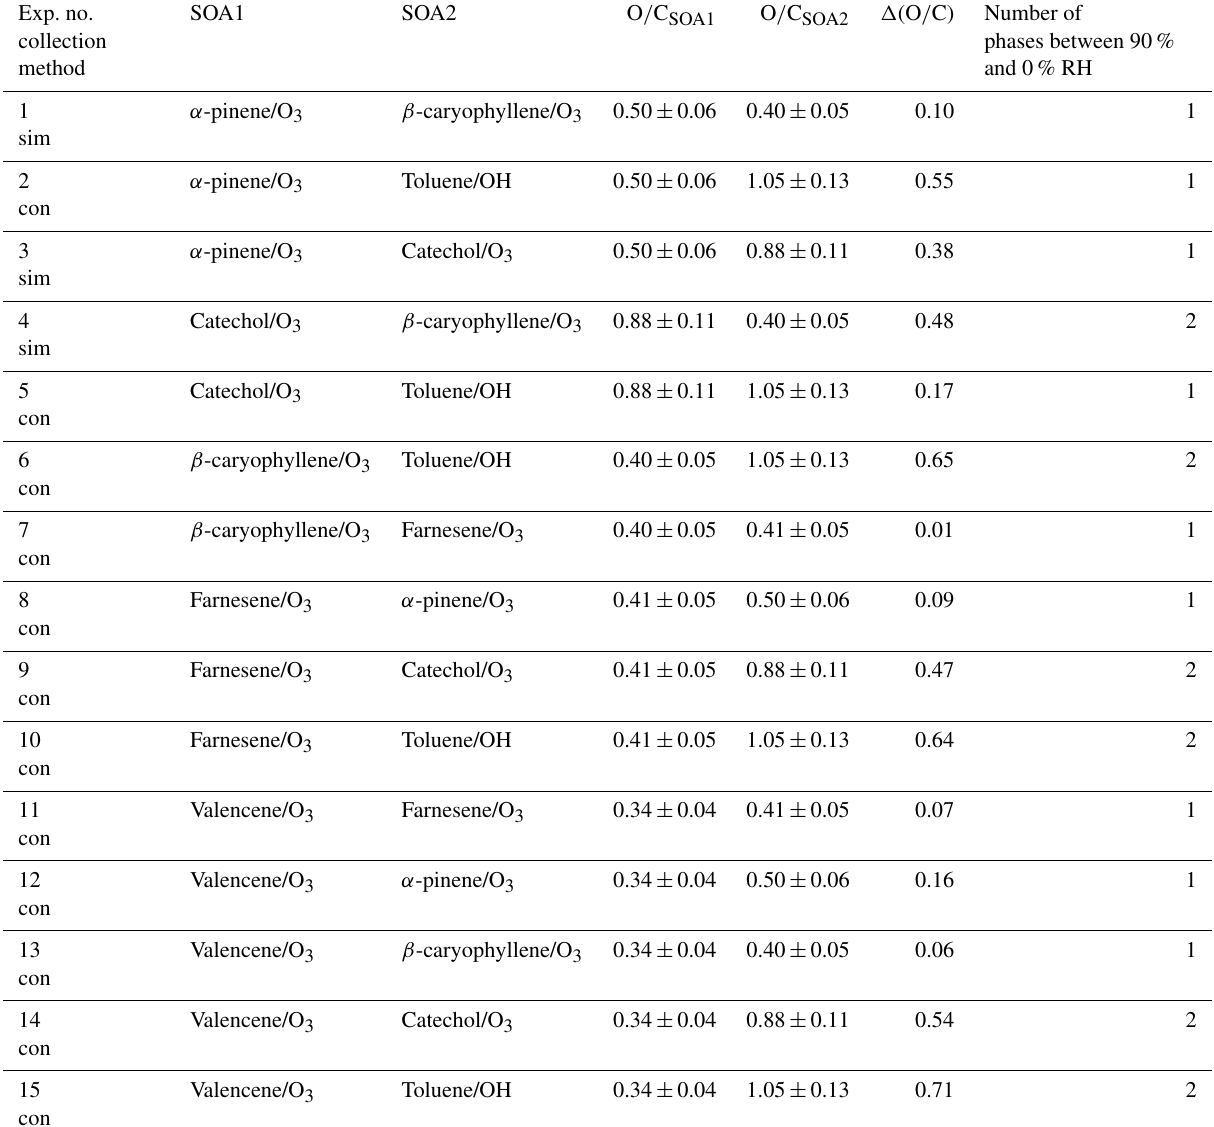
Table A1. List of phase behavior experiments of internally mixed particles containing two different types of secondary organic aerosol (SOA) material. Tabulated are the experiment number and the collection method, where “sim” denotes simultaneous generation and impaction and “con” denotes consecutive generation and impaction. Also listed are the average O / C ratios for the individual SOA types, as measured when only one VOC was present within the chamber (Table S3). The associated uncertainty in the calculated average O / C ratios is 12% (average absolute value of the relative error for multi-species organic aerosol; Canagaratna et al., 2015). The values of (cid:49) (O / C) denote the difference in the average O / C ratios of the two SOA types within a